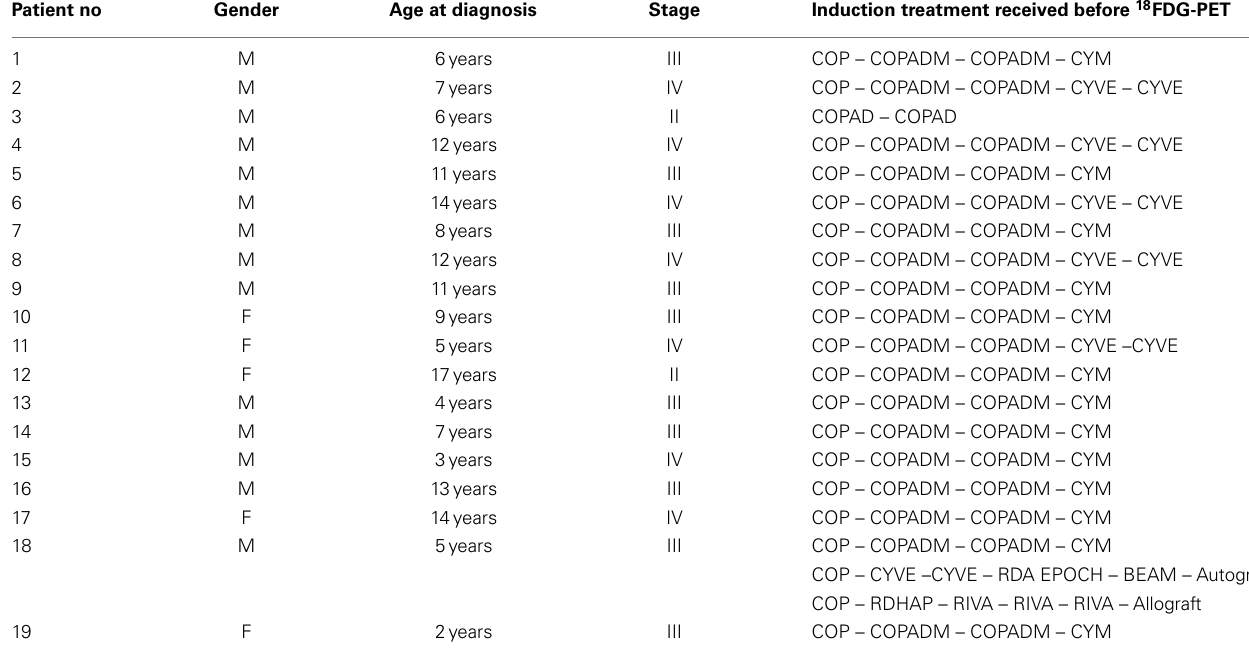
Table 1 | Population and induction treatment characteristics